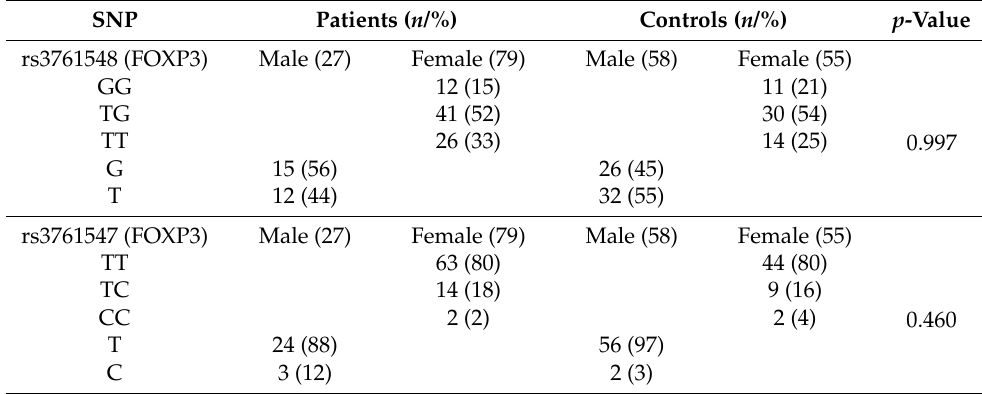
Table 3. Distribution of genotypic and allelic frequencies of the FOXP3 SNPs in MS patients and